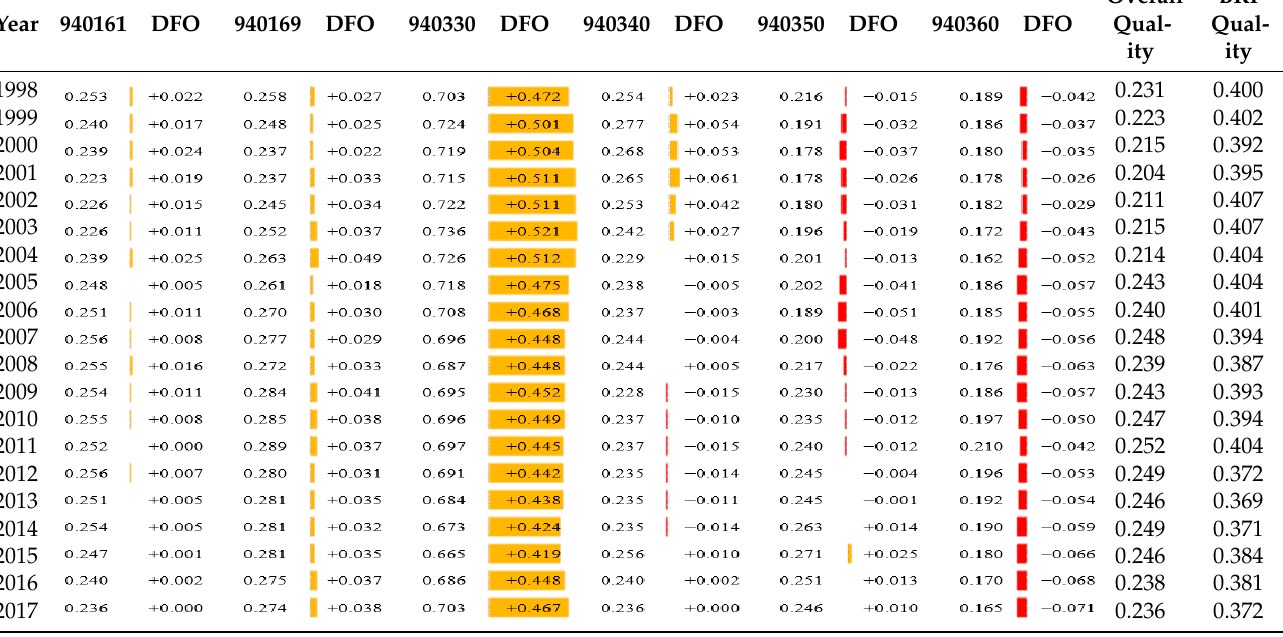
Table 7. Estimated quality of wooden furniture products by HS 6-digit category.